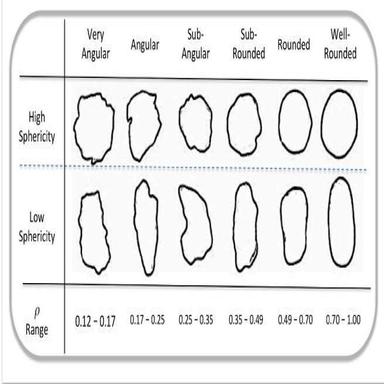
Example of a Powers chart showing general shapes and roundness indices (,).